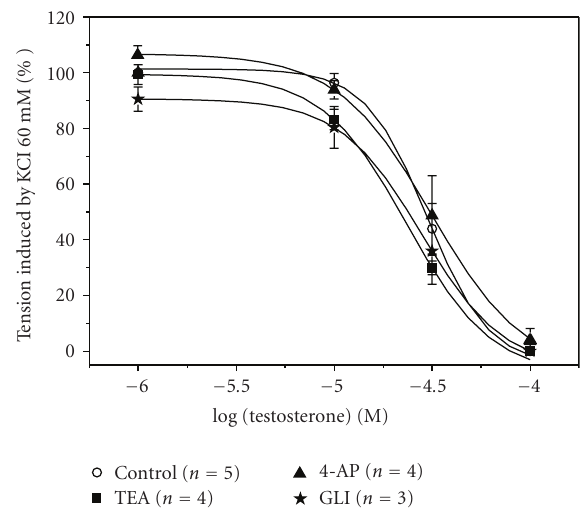
Figure 2: E ff ect of potassium channel inhibitors on rat aorta relaxation induced by testosterone. E ff ect of increasing concen- trations of testosterone (1–100 μ M) in endothelium-denuded rat aortic rings contracted with KCl (60mM) in presence or absence of the potassium channel inhibitors glibenclamide (GLI; 10 μ M), 4-aminopyridine (4-AP; 1mM), or tetraethylammonium (TEA; 1mM). Each point represents the mean value ± SEM (indicated in vertical bars) from the number of experiments shown in brackets.